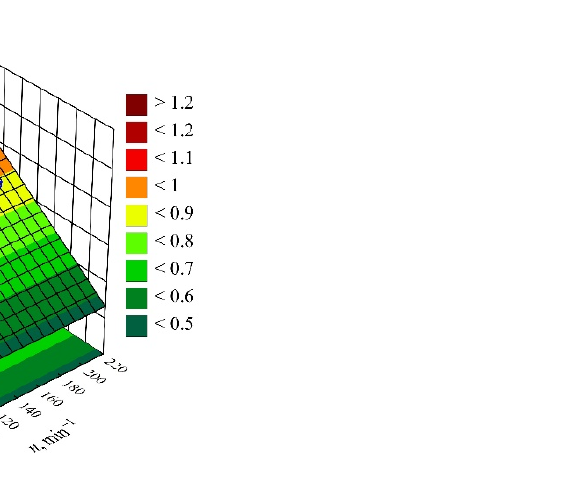
Figure 3. Pareto charts of the standardized effects for the empirical model of perpendicular shrinkage S P ; the vertical line in the plot corresponds to the arbitrarily chosen level of significance ( p = 0.05).